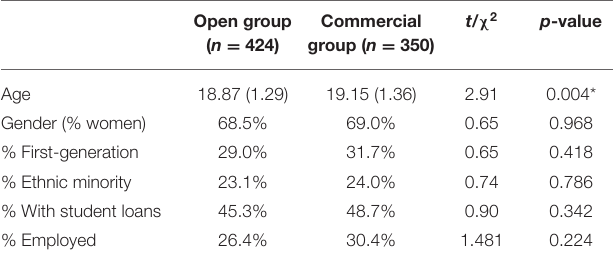
TABLE 1 | Sample characteristics by textbook